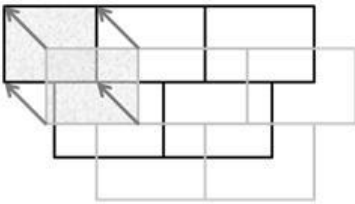
Figure 7. Computing vector displacement from the partial matching of features (the textured features are